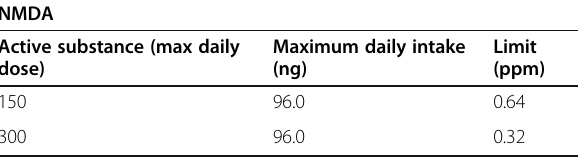
Table 3 Calculating maximum daily intake and parts per